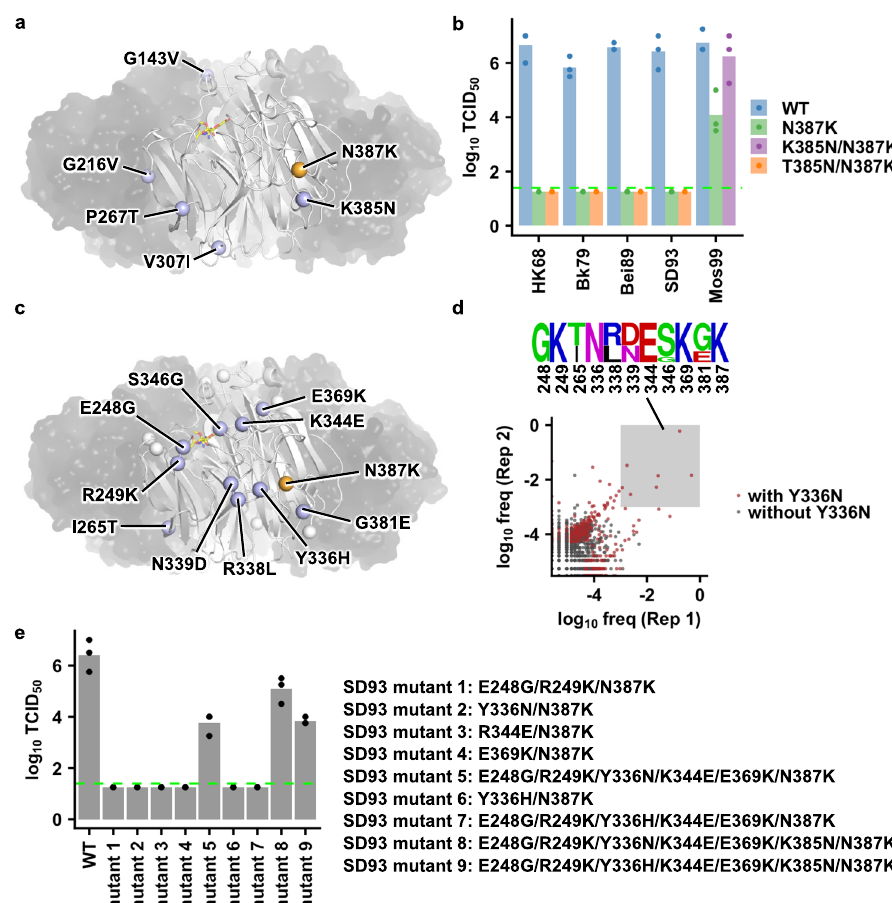
Fig. 2 | Permissive mutations for NA N387K in Mos99 and SD93. a Locations of natural mutations from Mos99 to Wy03 are shown as blue spheres on one proto- merof NA thatisinwhite cartoonrepresentation, whilethe otherthree protomers are shown as semitransparent black surface (PDB 3TIA) 21 . Location of N387K is shown as an orange sphere. Sialic acid in the active site is shown as yellow sticks. b The compensatory effects of mutating residue 385 to Asn in different chimeric H3N2 strains were examined by a virus rescue experiment. c Locations of natural mutations from SD93 to Mos99 are shown as blue or white spheres on one pro- tomer of NA that is in white cartoon representation, while the other three proto- mers are shown as semitransparent black surface (PDB 3TIA) 21 . Blue spheres represent the mutations that were included in the SD93 combinatorial mutant